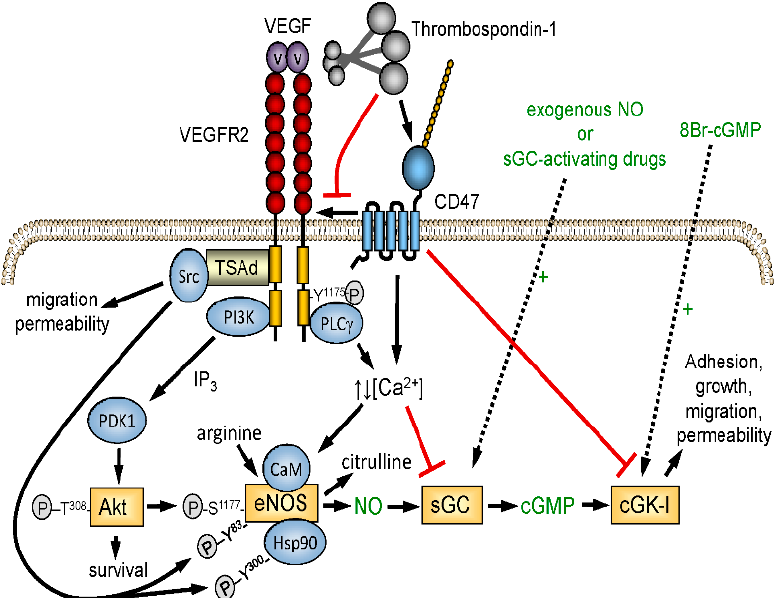
Figure 2. Redundant regulation of NO signaling by TSP1–CD47 interaction. Endogenous NO synthesis is stimulated via Akt-mediated phosphorylation of endothelial nitric oxide synthase (eNOS) downstream of the VEGF receptor VEGFR2. Ligation of CD47 by TSP1 also inhibits activation of soluble guanylyl cyclase (sGC) mediated by endogenous or exogenous NO. TSP1 also inhibits calcium-dependent activation of eNOS and NO signaling downstream of cGMP by inhibiting cGMP-dependent protein kinase (cGK-1).